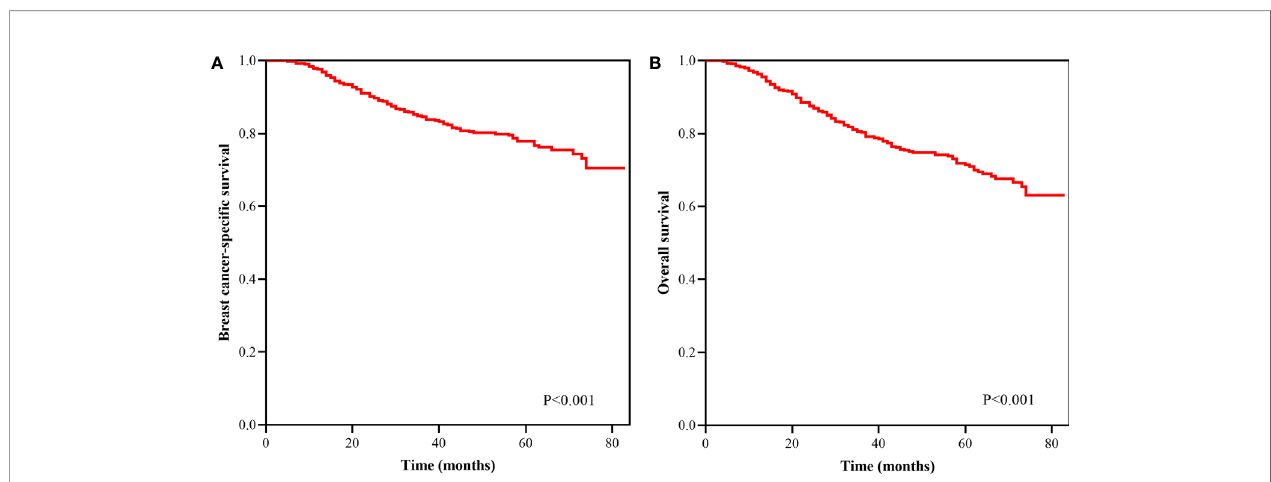
FIGURE 1 | Kaplan – Meier survival curves of breast cancer-speci fi c survival (A) and overall survival (B) in breast cancer patients with internal mammary lymph nodes metastasis.